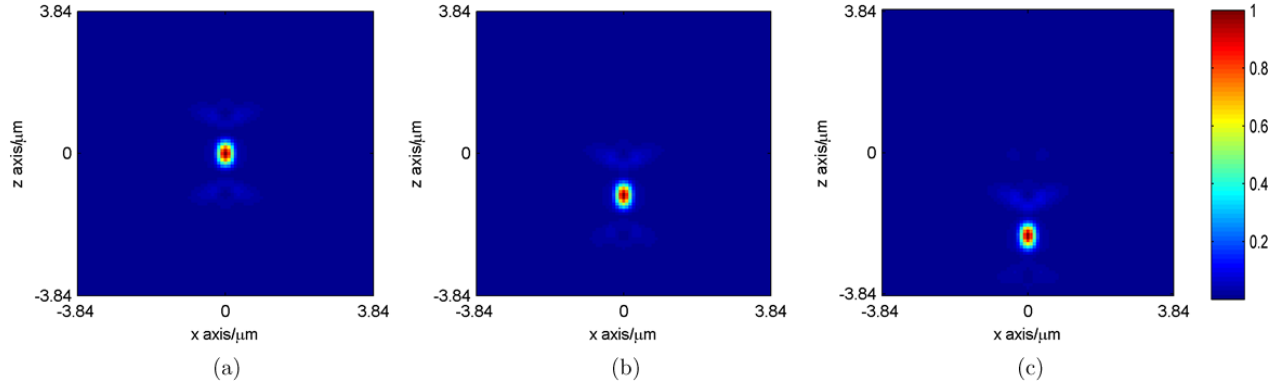
Fig. 8. The overall point spread function of center light sheet in x ; z plane.